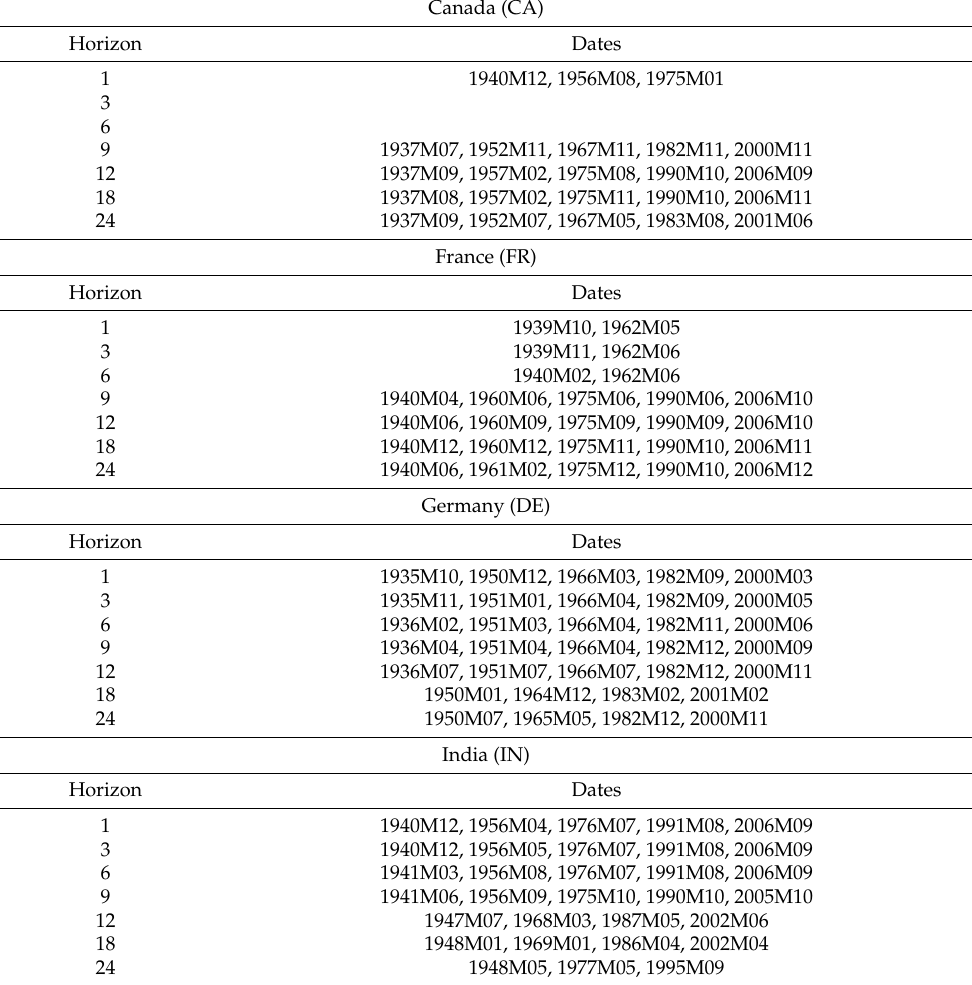
Table A3. Multiple structural break test